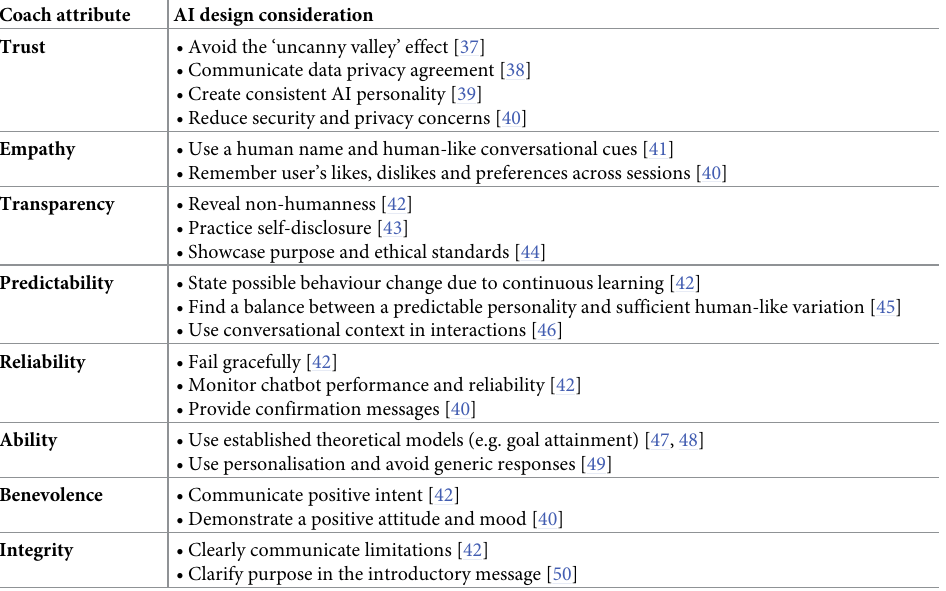
Table 1. AI design practices to support strong coach-coachee